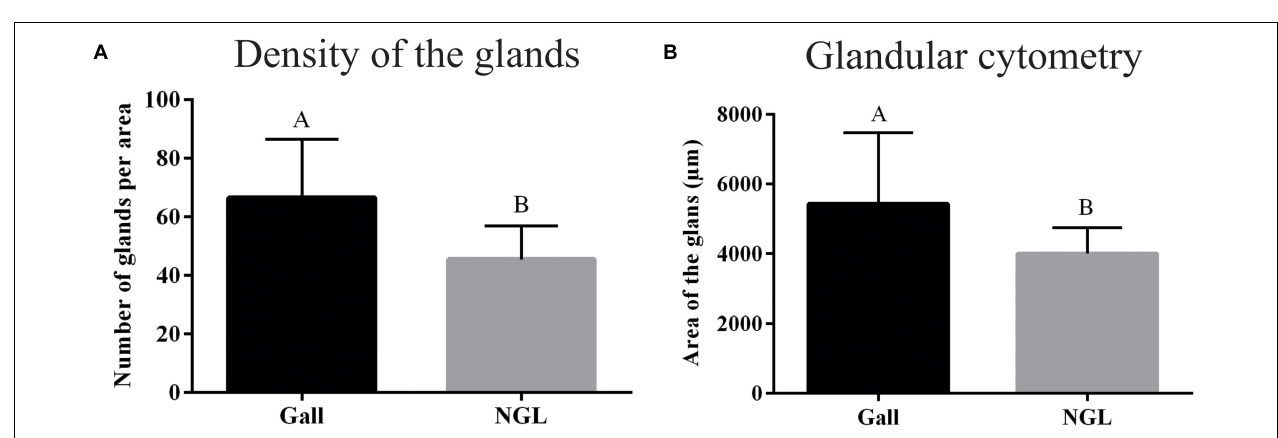
FIGURE 2 | Oviposition inside the tissues of a M. splendens rolling gall induced by an undescribed species of Nexothrips (suborder Terebrantia). (A) Initial development of the larva inside gall tissues. (B) Development of the larva. (C,D) Larvae hatching out of gall tissues. (C) Anatomy of a gall, evidencing hatching out of the leaf tissue. (D) MEV slides evidencing the hatching. L: Larva, OV: oviposition, HR: Hypersensitive area. Scale bars: A–C : 50 µ m; D : 10 µ m.